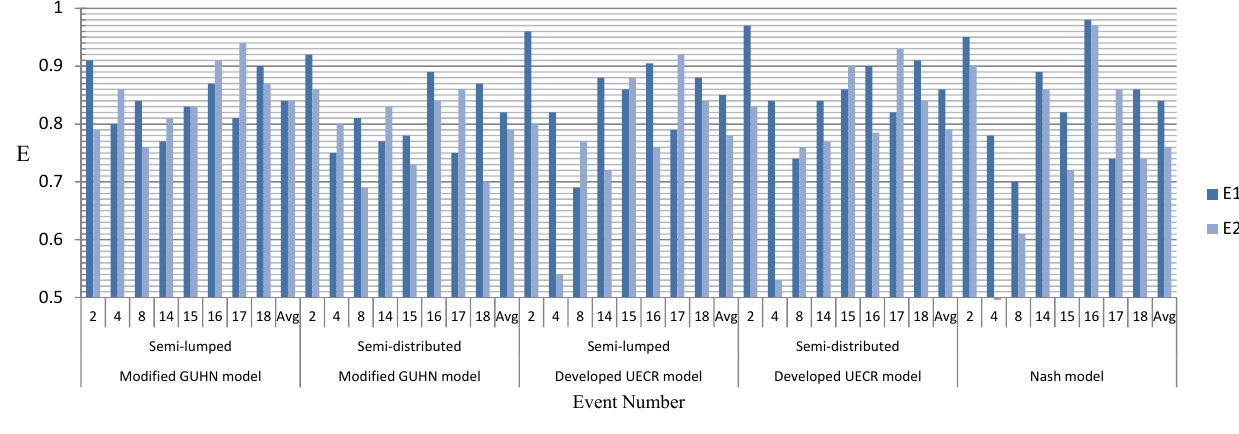
Figure 10. Verification